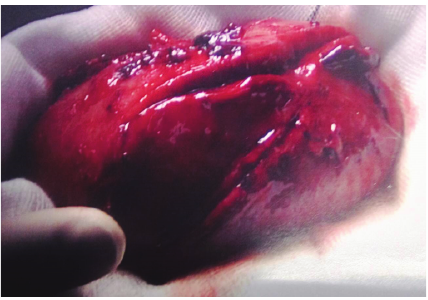
Figure 1: Explanted kidney showing a longitudinal rupture on the convex